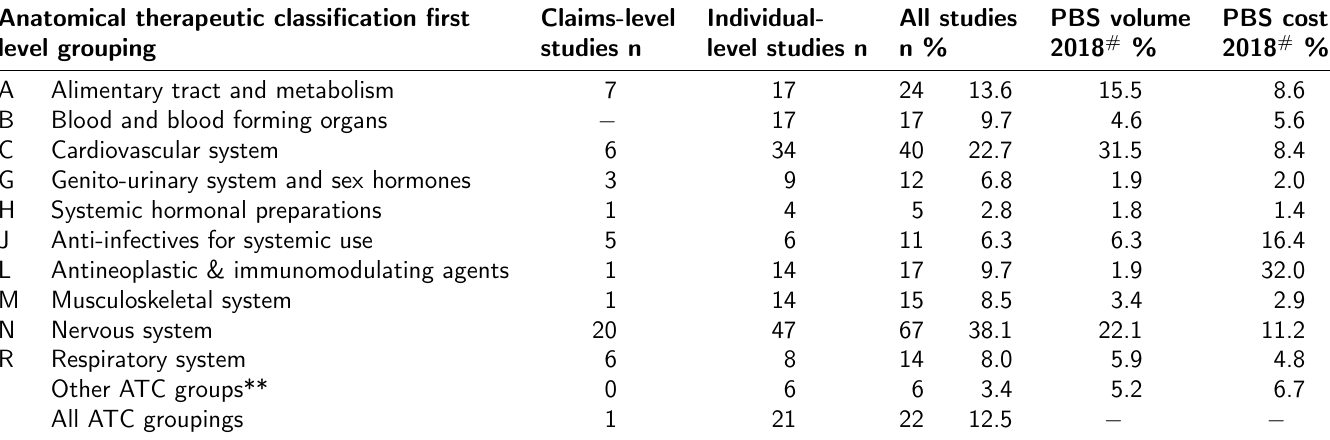
Table 2: Number and proportion of studies by pharmacological group compared to PBS volume and PBS expenditure (2014–2018). Study could be classified under more than one pharmacological group (N = 176 ∗ ) Anatomical therapeutic classification